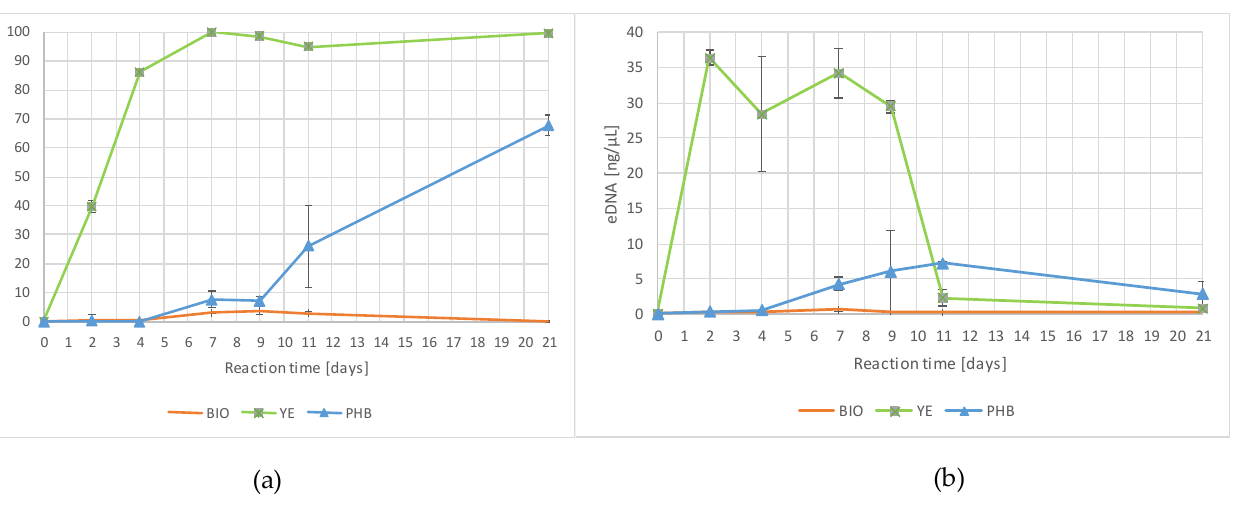
Figure 2. ( a ) Percentage of Cr(VI) removal and ( b ) eDNA content observed during the experiment in the viable reactors.